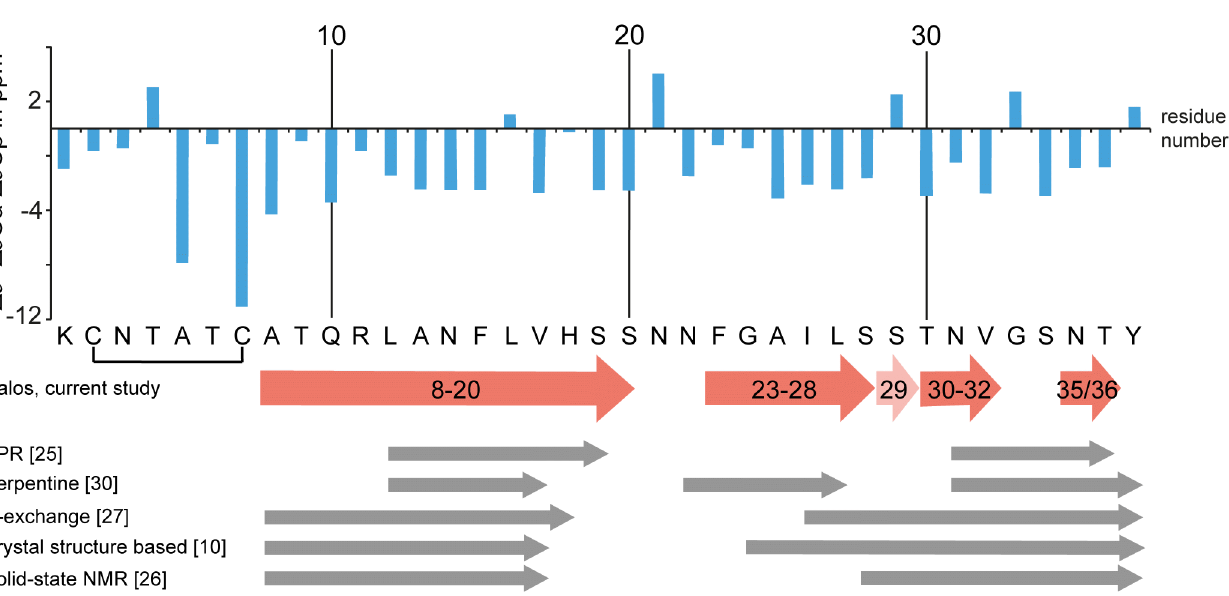
β -strand. Bottom, red arrows represent the β -strands